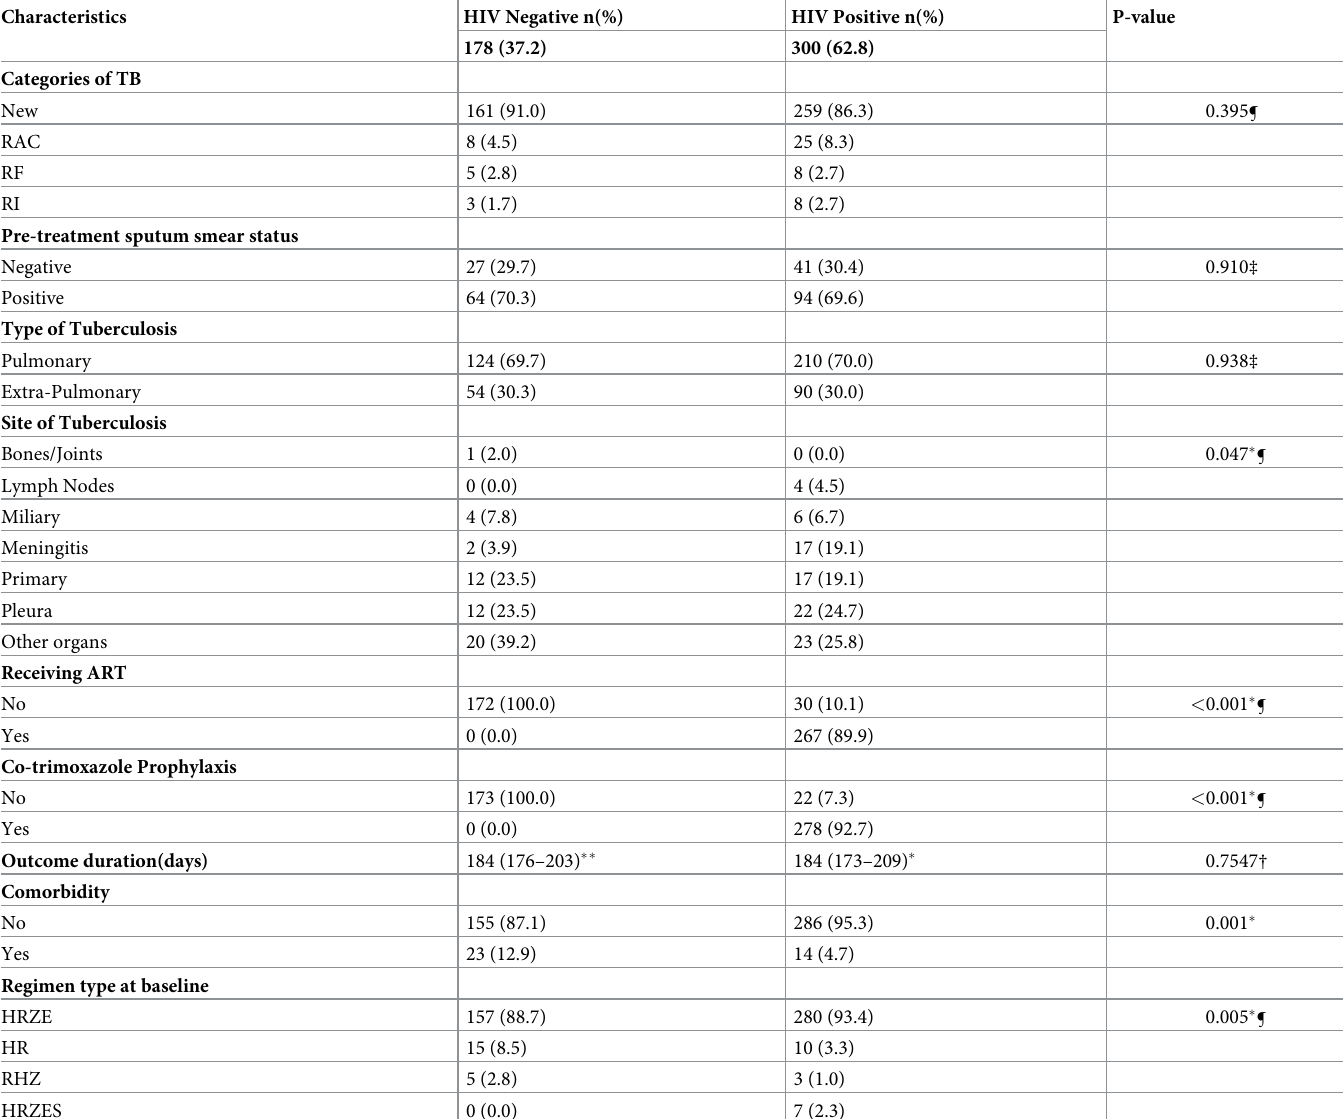
Table 4. Characteristics of TB patients presenting to Elim Clinic on the basis of HIV